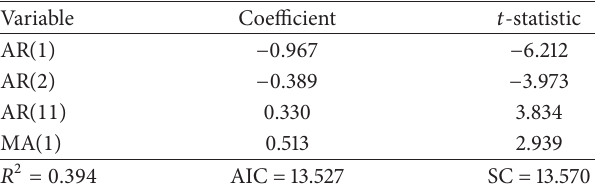
Table 4: The parameters estimate of the ARIMA model.